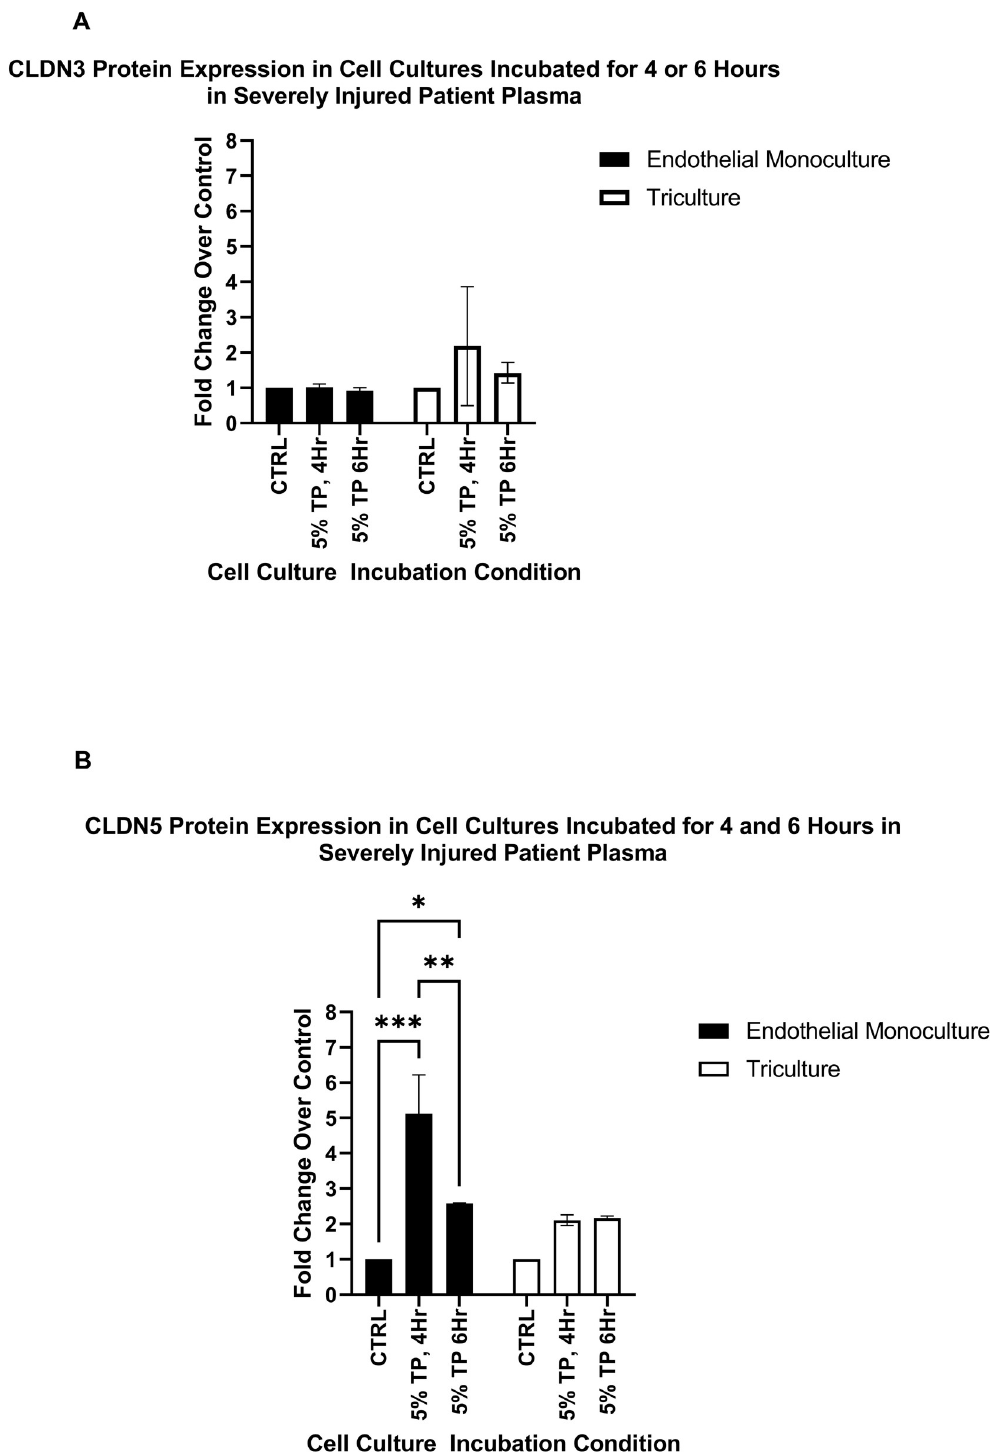
Fig 3. CLDN5, and CLDN3 protein expression following a 4- or 6-hour incubation with 5% plasma from severely injured patients. (A) CLDN3 protein expression: We observed no significant change in fold change of CLDN3 expression was observed in either the endothelial monoculture or triculture, n = 2 (B) CLDN5 protein expression: Endothelial monoculture showed a 5.12- and 2.58-fold change increase vs. control following 4 and 6 hours of incubation respectively with 5% severely injured plasma. p < 0.001, p < 0.05, n = 2; There is a significant difference between the fold change at 4